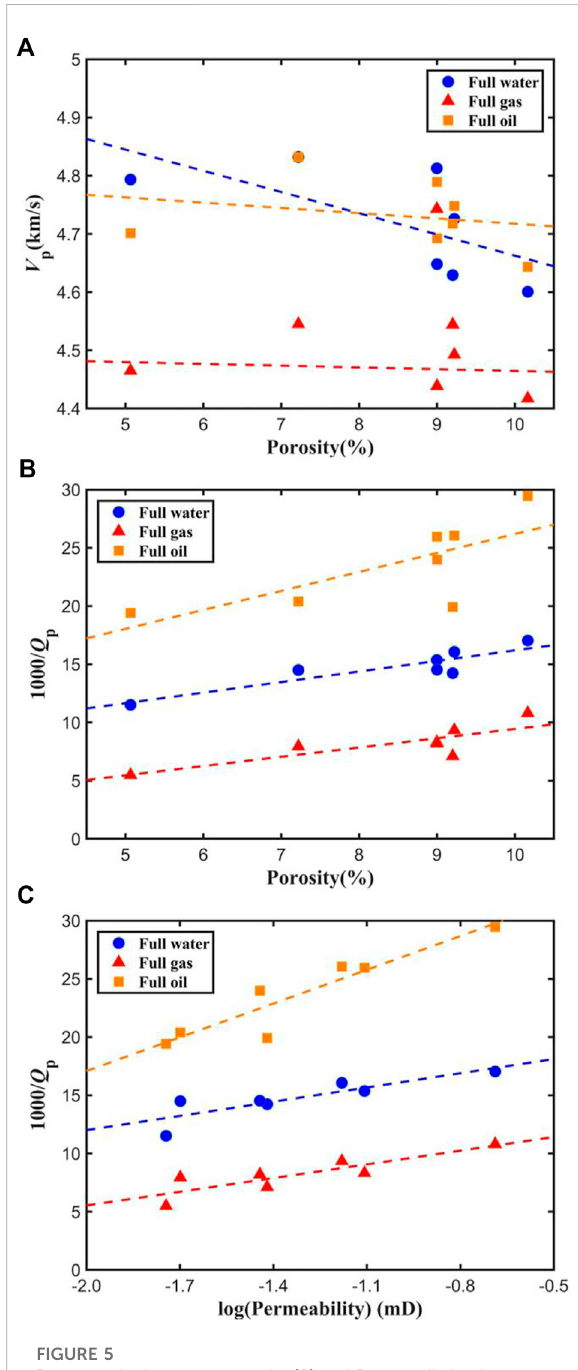
FIGURE 5 P-wave velocity versus porosity (A) and P-wave dissipation factor as a function of porosity (B) and permeability (C) at a con fi ning pressure of 30 MPa and different full